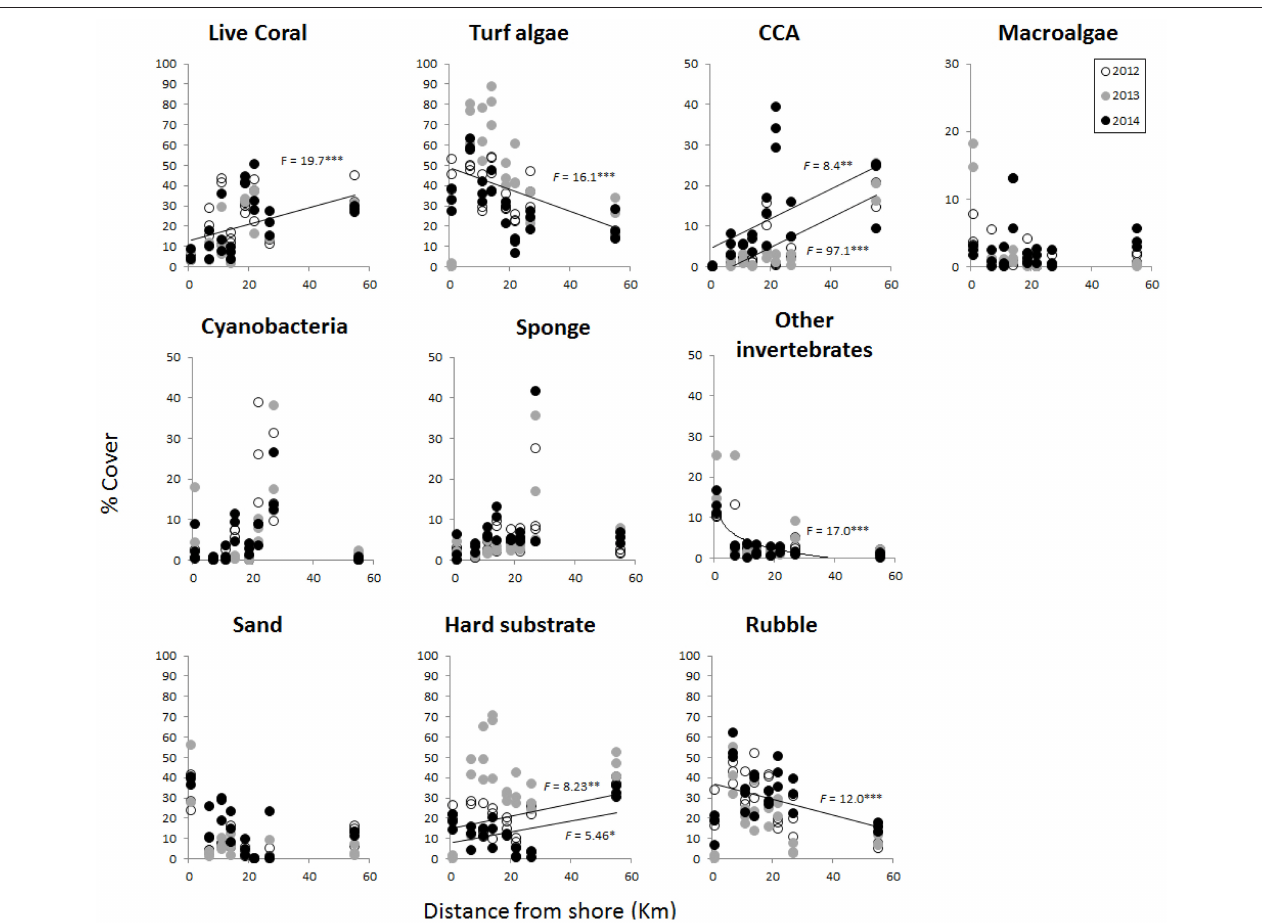
FIGURE 5 | Percentage of benthic cover of dominant groups of coral reef organisms and substrate type measured at each site in 2012 (white), 2013 (gray), and 2014 (black). Sites are represented by distance from shore (km) on the x-axis. Regressions are indicated for variables that showed a significant increase or decrease with distance, after testing first for differences across years and pooling years that were not significantly different from each other (PERMANOVA, results from Table S2). Full results from regression analyses, equations and R 2 values are shown in Table 2 . Asterisks indicate level of significance (***Indicates < 0.001, **Indicates > 0.001 and < 0.1, *Indicates > 0.01 and <